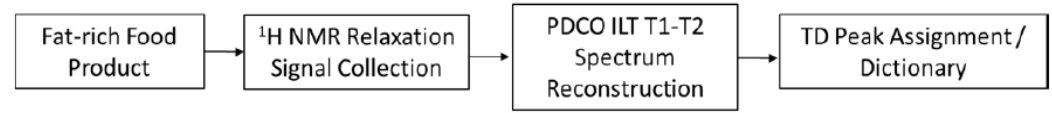
Figure 3. Concept and main components of 1 H LF NMR sensor for food application.